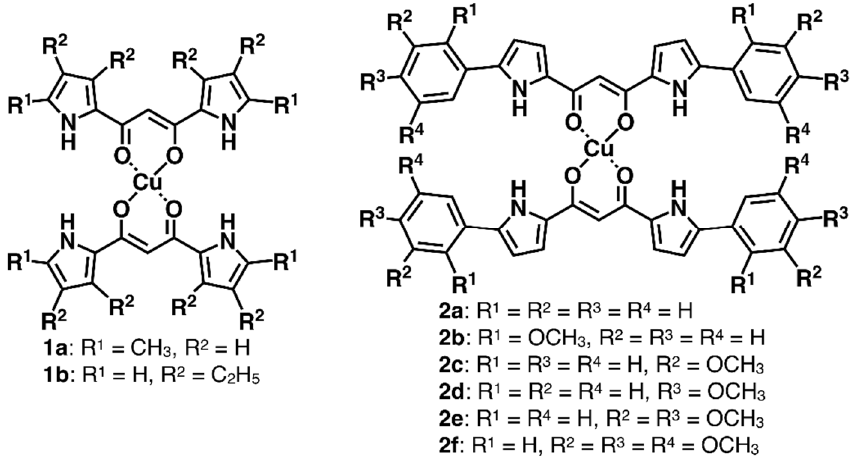
Figure 2. Dipyrrolyldiketone Cu II complexes 1a , b and 2a – f . The pyrrole positions bearing R 1 and